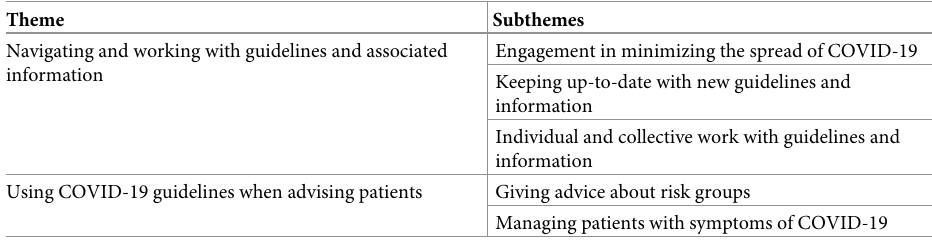
Table 3. Themes from the